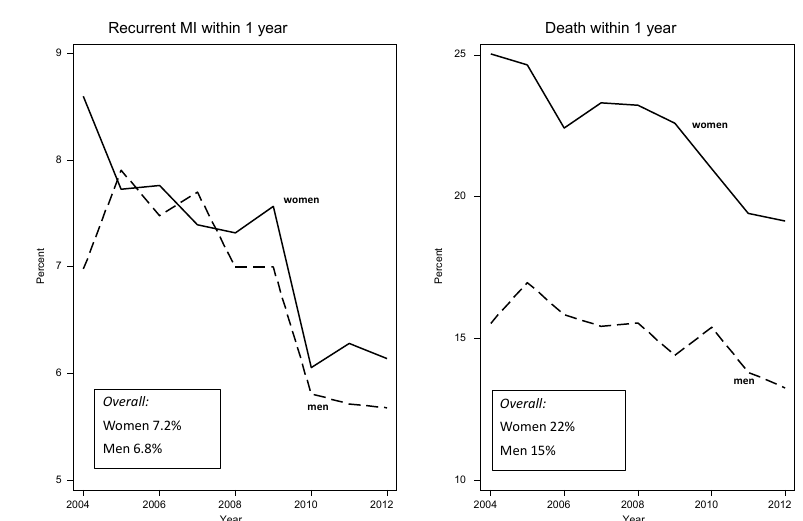
Figure 4. Probability of survival from cardiac treatment in Florida emergency departments, 1991– 2010, showing results separately according to the sex of the physician attending and the sex of the patient. This figure was drawn using approximate results derived from the source paper [15].